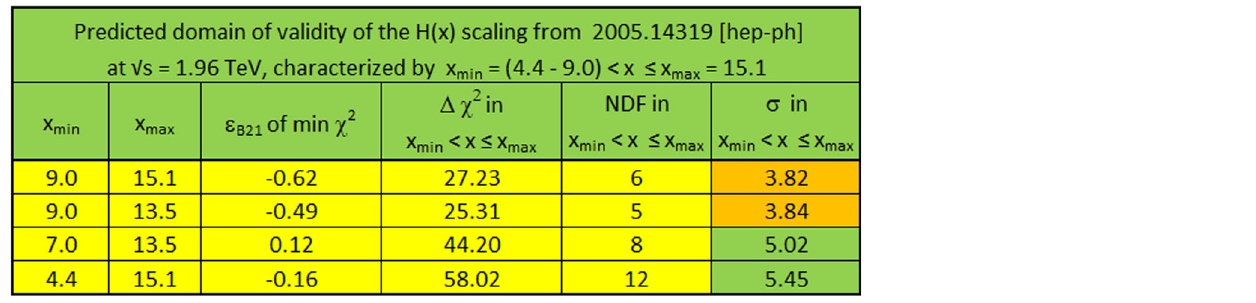
Table 13 In the 9 . 0 < x = − tB ≤ 15 . 1 kinematic domain we obtain a lower, model dependent limit of significance of 3.82 σ . Note, that the ReBB model is not validated in the − t ≤ 0 . 372 kinematic range [42], √ s = 1 . 96 TeV, this lower limit corresponding to low values of x . At of validity of the ReBB model is x min = 4 . 4. In the